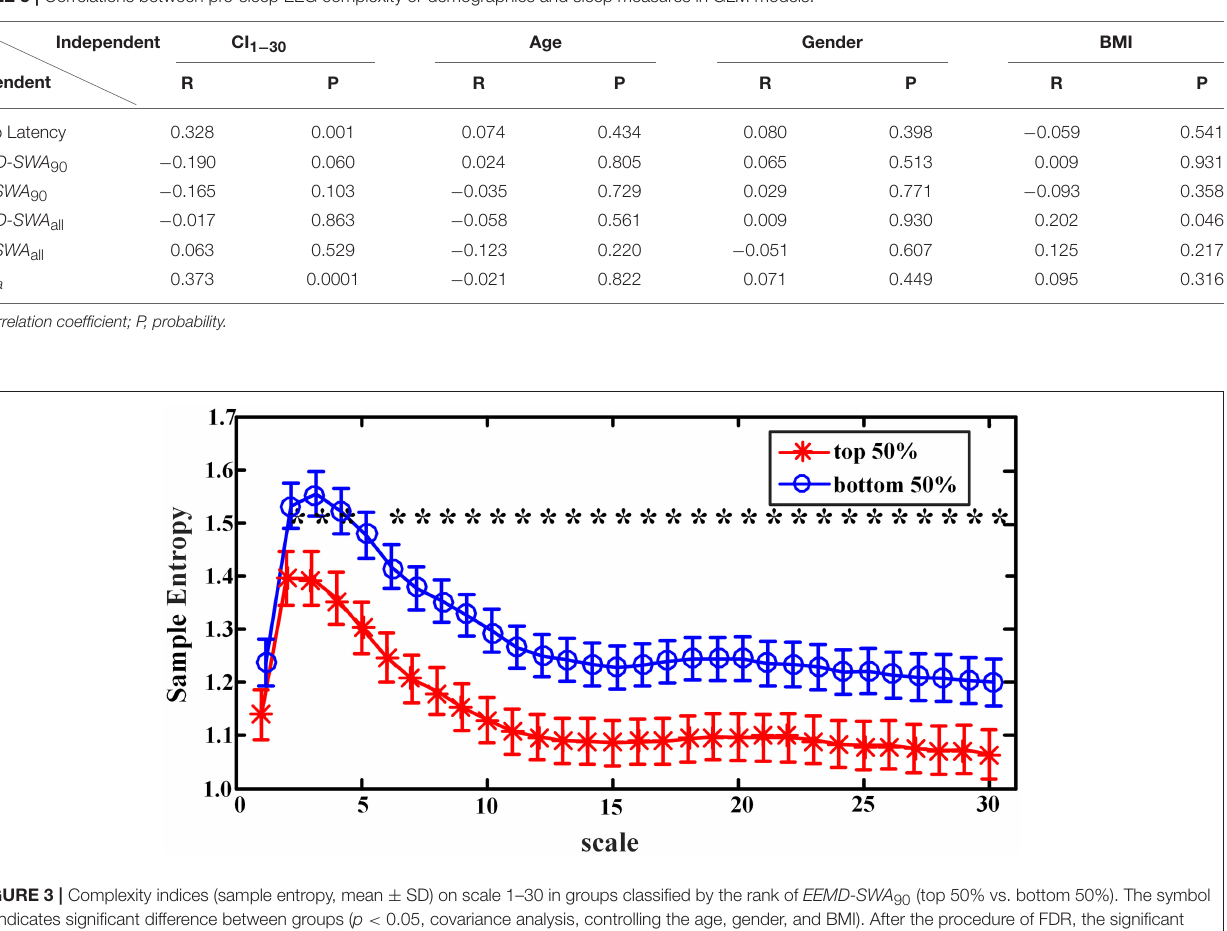
TABLE 3 | Correlations between pre-sleep EEG complexity or demographics and sleep measures in GLM models.